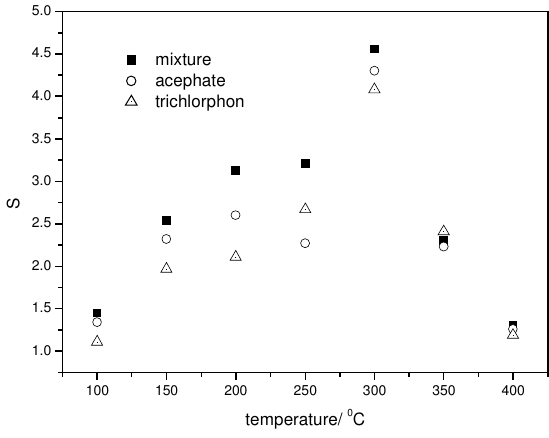
Figure 2. The sensitivity as a function of 0.1ppm trichlorphon , acephate gas and 0.2ppm mixture respectively at different